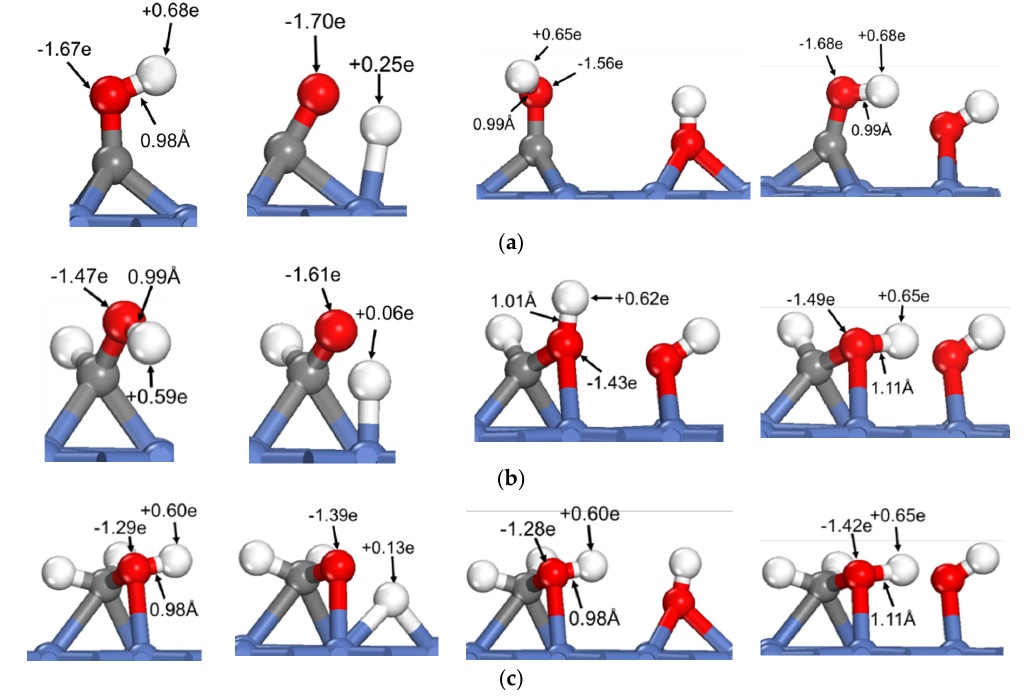
Figure 1. Activation energies of dual path dehydrogenation of oxhydryl in H x CO–H* ( x = 3, 2, 1, 0). To reveal the common feature of oxhydryl dehydrogenation in different H x COH*, Figure 2 shows the structures and Bader charges of H x COH*, with and without OH* co-adsorption, at their initial local minimum geometries and reaction transition states. As seen in Figure 2, the Bader charges of oxhydryl H for isolated H x COH* at their local minimum and transition state structures are on average +0.63 e and +0.14 e, respectively. Clearly, the Bader charges of oxhydryl H of isolated H x COH* at their local minimum and transition state structures are quite different. That is, a significant charge density redistribution is required in the reaction path going from a local minimum energy structure to a transition state configuration. A large electronic energy changes due to the orbital reorganization, or correspondingly a high energy barrier, is expected in the O–H scission process. In comparison, the Bader charges for oxhydryl H of H x COH* with co-adsorbed OH* are on average +0.59 e and +0.65 e at the minimum energy and transition state structures, respectively. There are little charge redistributions required in the bond scission reaction paths. Combined with the fact that the O–H bond of H x COH* is floppy, a very low activation energy is encountered for each of the